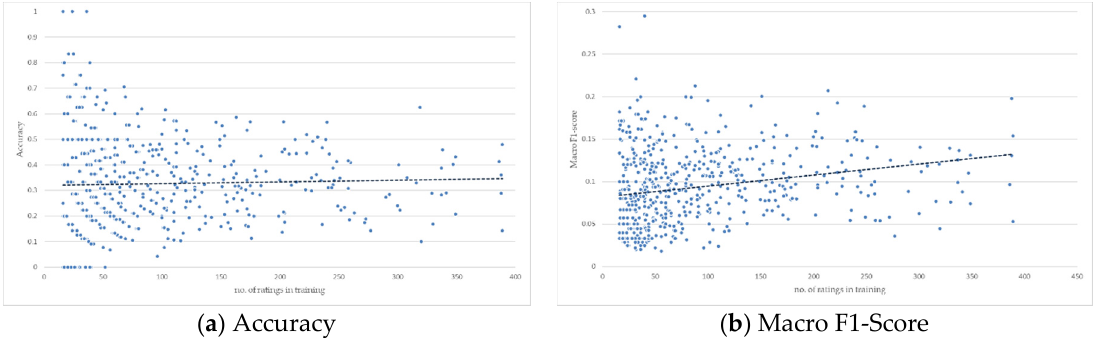
Figure 25. Change in measured values according to the number of ratings in training (Exp. 3).